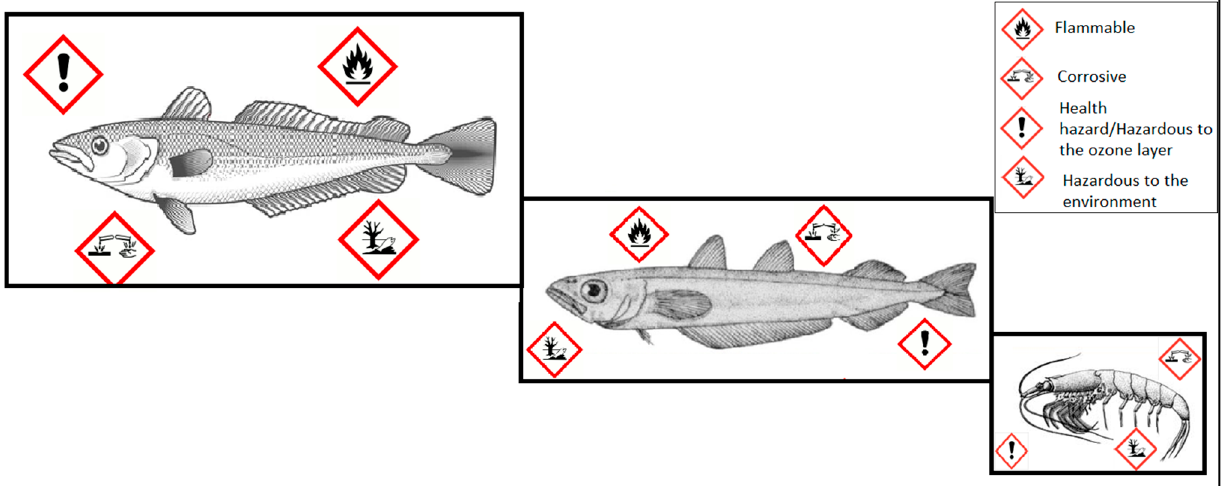
Figure 2. Risk assessment based on the chemicals found in hake, whiting and shrimp (from left to right) in this study, illustrated from hazard pictograms taken from ECHA.